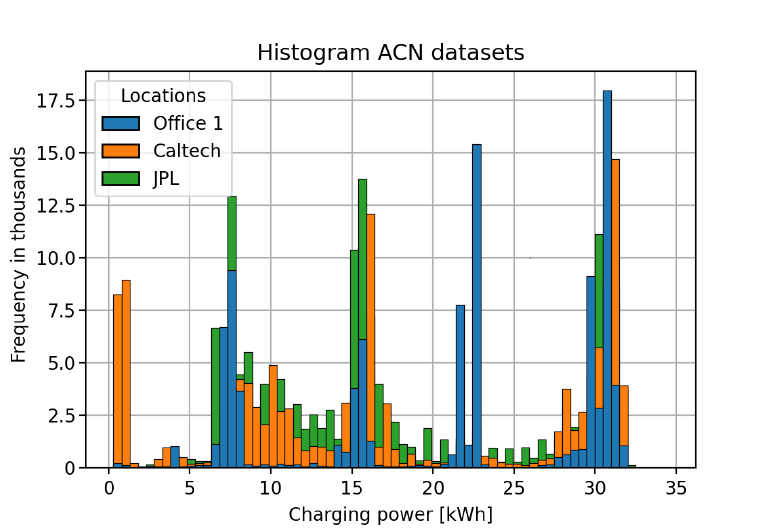
Figure 3. Histogram of the charging capacities of all charging processes of the ACN